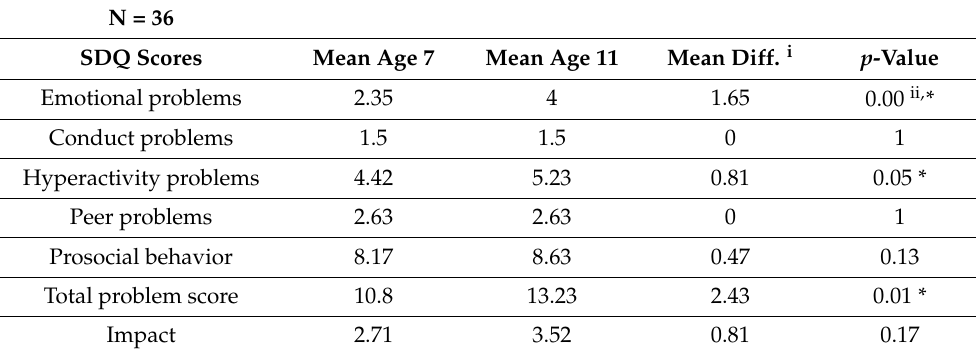
Table 2. Parent-reported mean scores and mean differences assessed using the Strengths and Difficul- ties Questionnaire (SDQ) at ages seven and eleven for a cohort of children with Cerebral Palsy. N = 36 SDQ Scores Mean Age